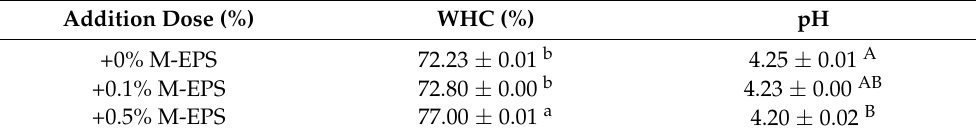
Table 6. Water holding capacity (WHC) and pH in set yogurt with the presence of M-EPS. Addition Dose (%) WHC (%) pH +0% M-EPS 72.23 ± 0.01